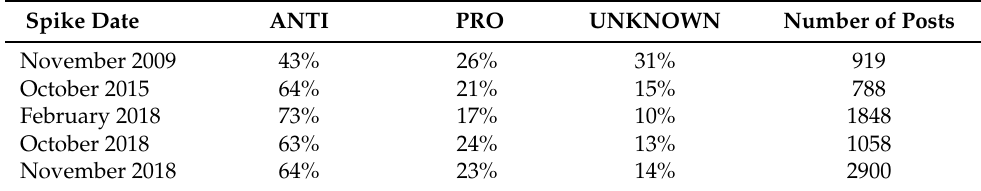
Table 1. Ratios of anti- and pro-vaccination posts analyzed by human raters for some of the prominent peaks of activity detected by the keyword search algorithm. The table also contains the ratio of posts for which assignment was